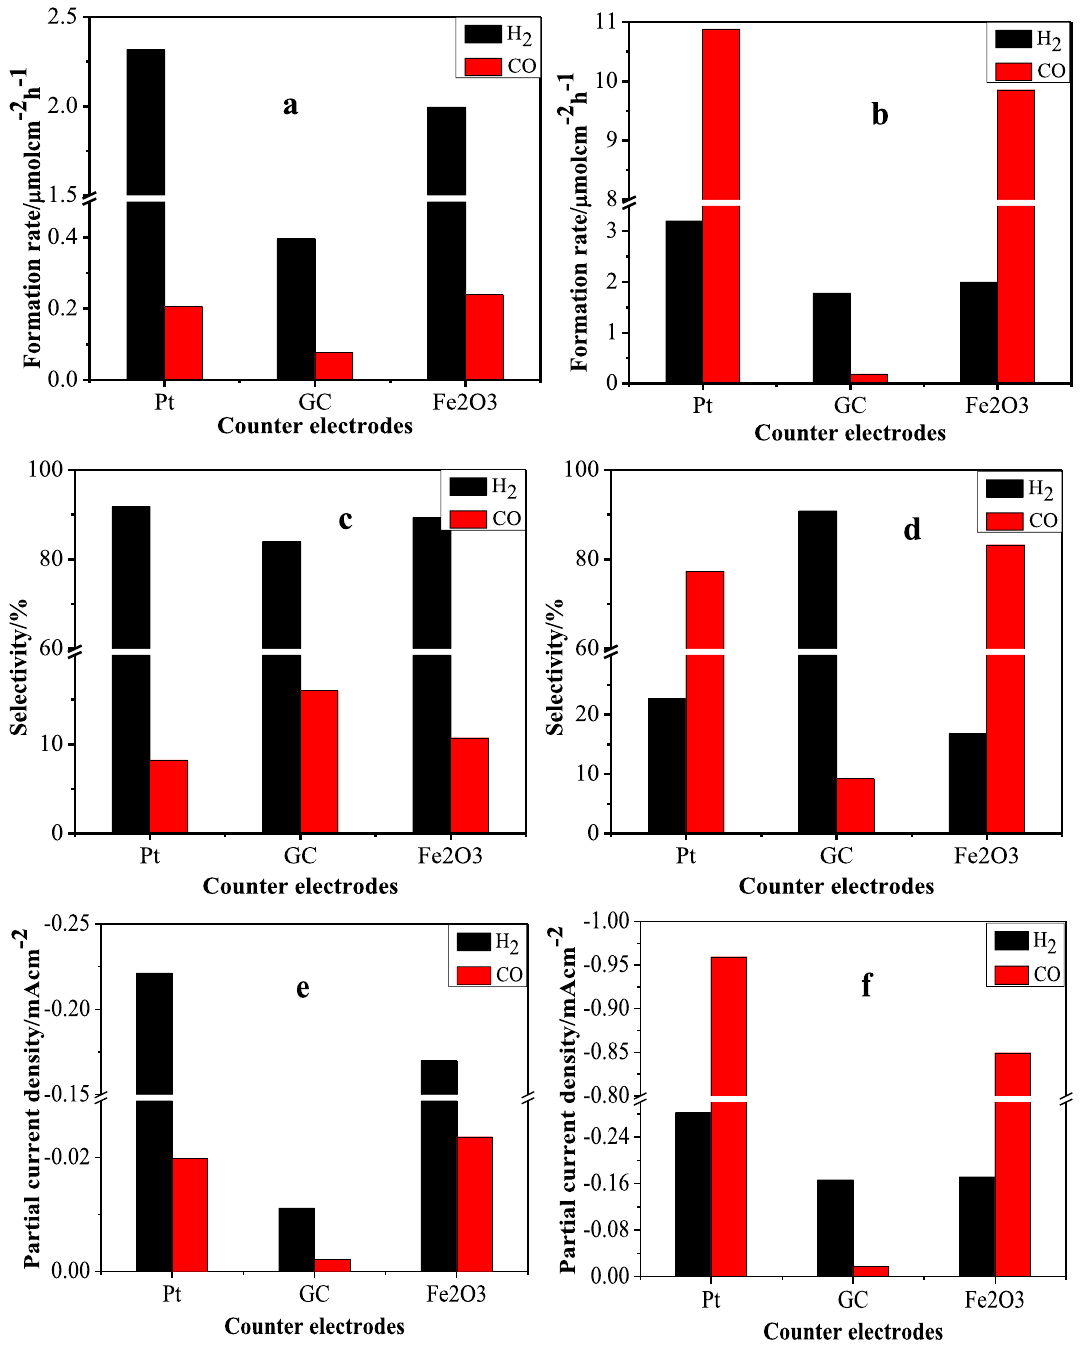
Fig. 5 Parameters of electrochemical CO − 0.6 V, and partial current densities at; e − 0.4 V, b − 0.6